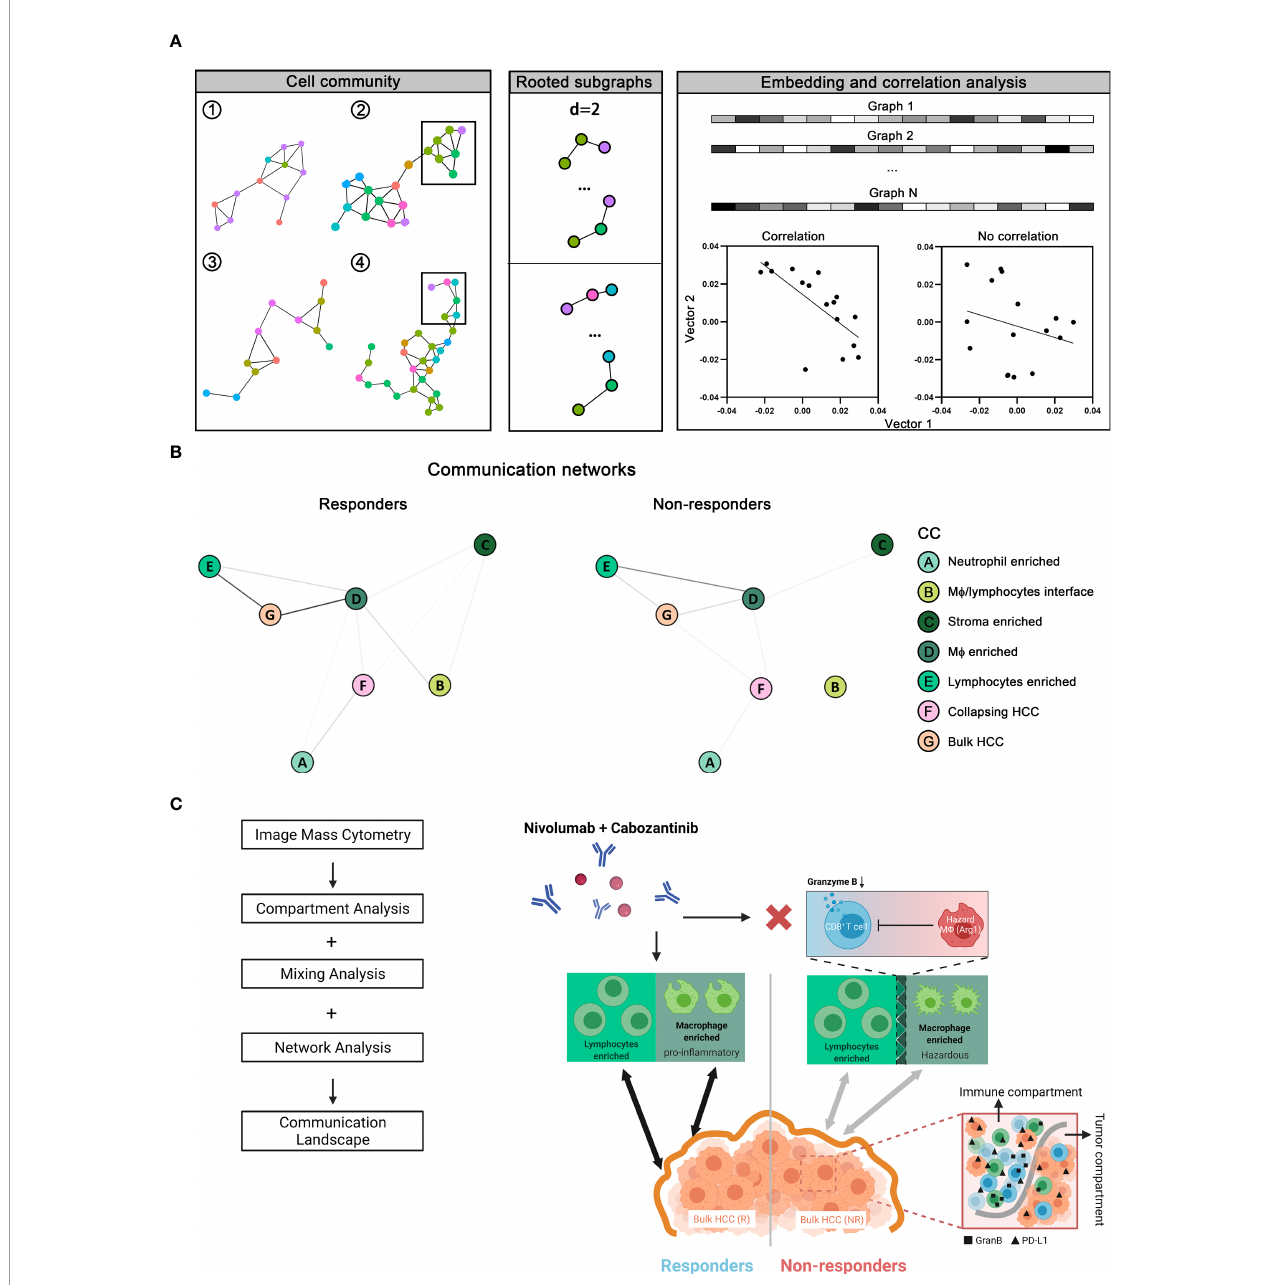
FIGURE 7 | Network analysis of communication landscape modeling of the tumor microenvironment in responders versus non-responders. (A) Cellular communities (CCs) from all cores (n = 37) identi fi ed as previously described were converted to graph-embedded vectors. Correlation tests were then performed to assess the association between each given pair of vectors. (B) Correlation test results give rise to two distinct communication maps in tumor microenvironment associated with responders and non-responders. (C) Results from network analysis, together with compartment and mixing analysis, were summarized into communication landscape models that link to the therapy